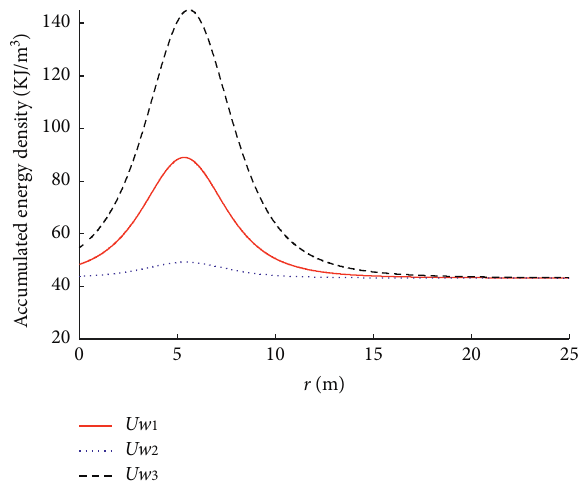
Figure 6: The quasi static energy distribution of surrounding rock mass.